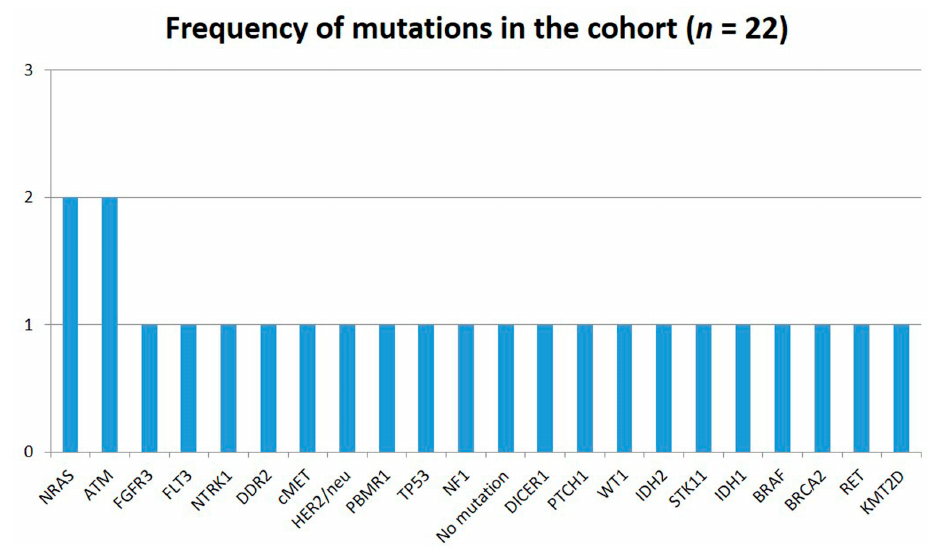
Figure 1. Mutational profile (frequency of mutations) of 22 samples from advanced myeloma patients (all beyond third line settings) using a next-generation sequencing (NGS) assay.